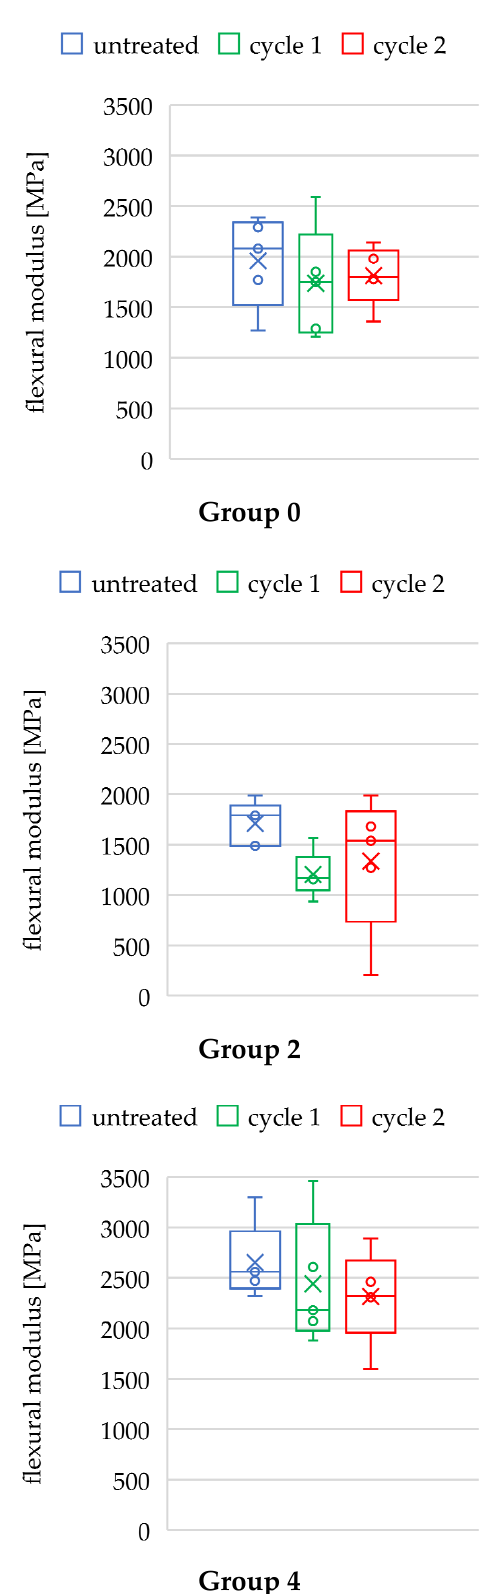
Figure 4. Boxplots: flexural moduli of the different groups and subgroups. The x represents the mean, the circles represent data points not covered by the boxplots.